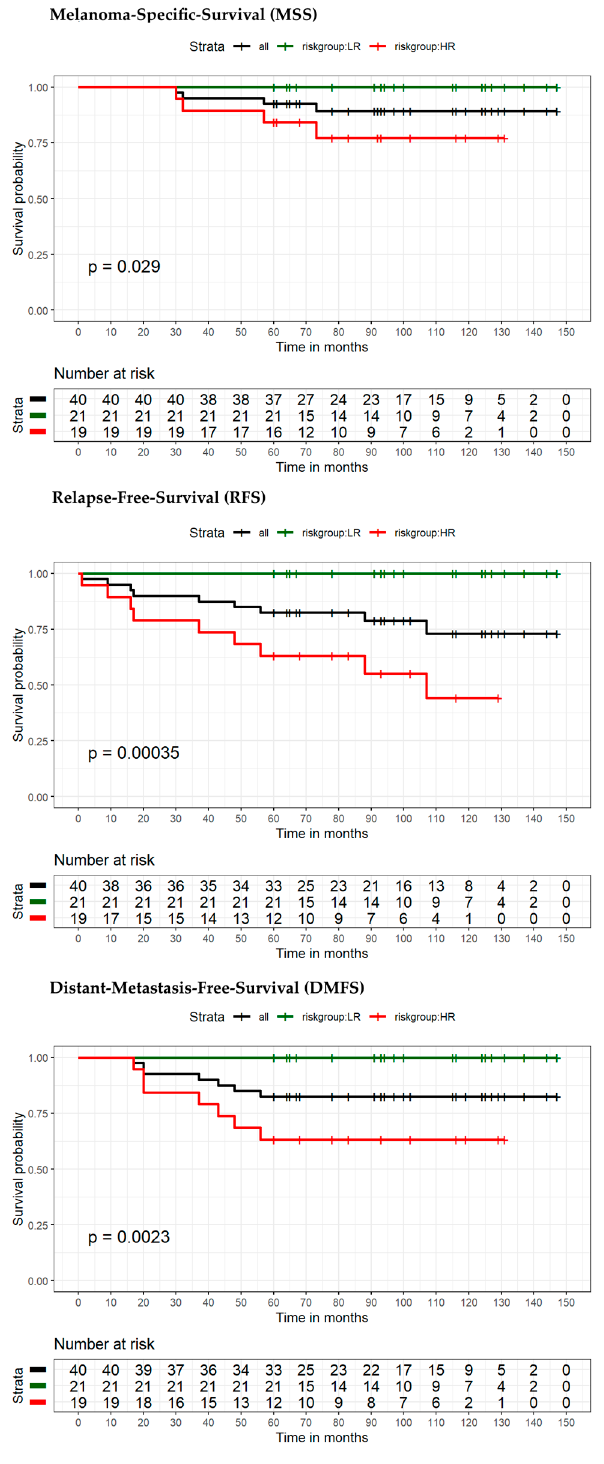
Figure 5. Kaplan–Meier analysis of the sub-cohort with AJCCv8 stages IB—IIA stratified into high- risk or low risk-by the seven-marker signature. Survival estimates for the endpoints MSS, RFS, and DMFS at 5- and 10-year follow-up are displayed for: high-risk (in red), low-risk (in green), and all patients (black).